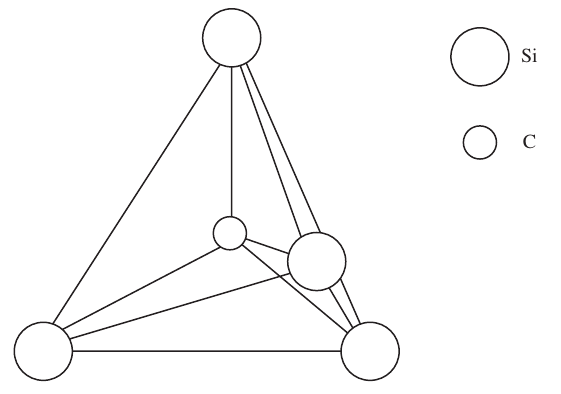
Figure 1. Representation of basic silicon carbide thetraedra.